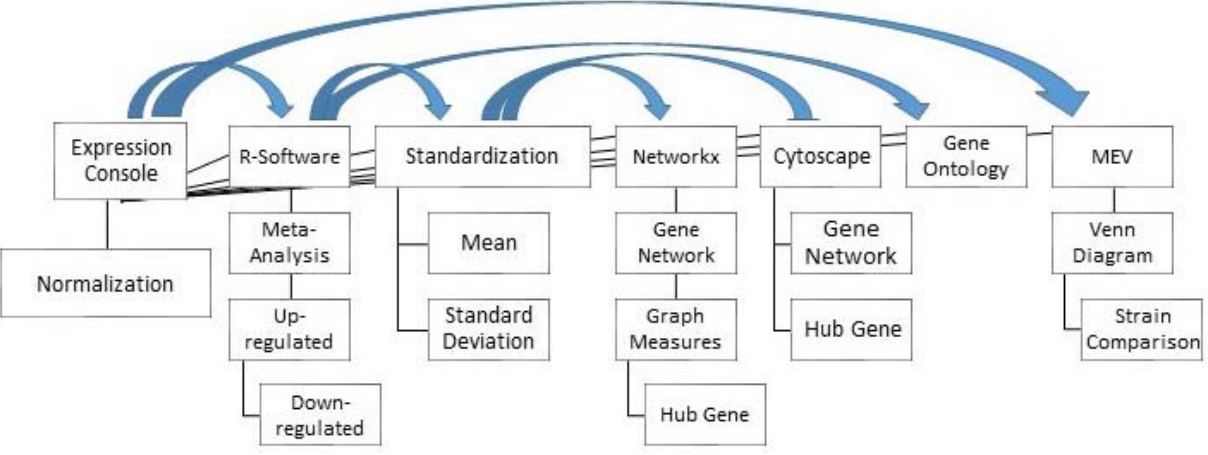
Figure 3. Analysis pipeline used in this study (Arrows indicate where results from one software were used as input for another program). MEV = multiple experiment viewer. used as input for another program). MEV = multiple experiment